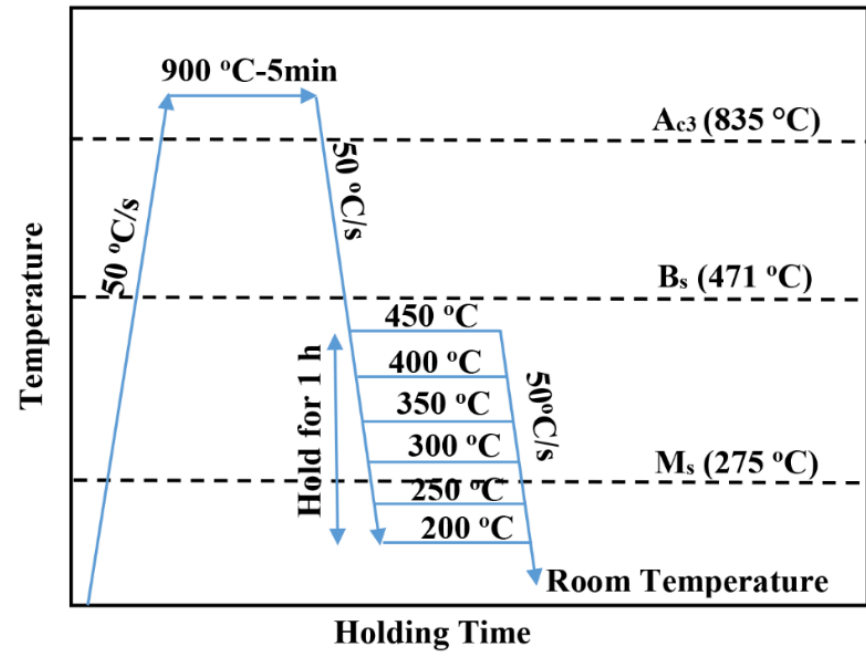
Figure 1. Schematic of the typical heat-treatment processes.